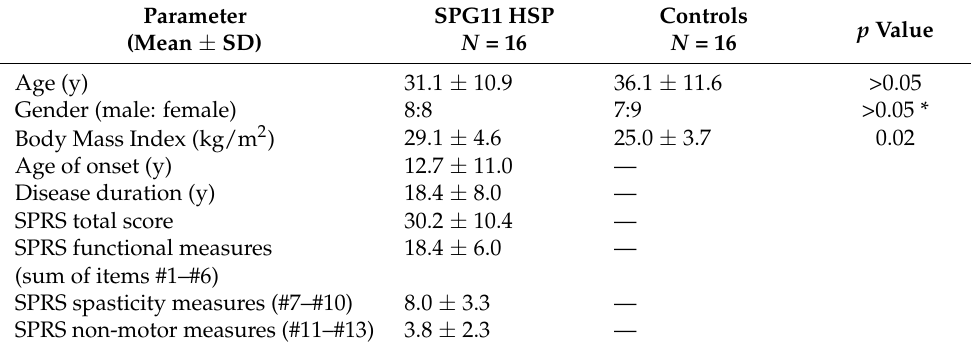
Table 1. Patient